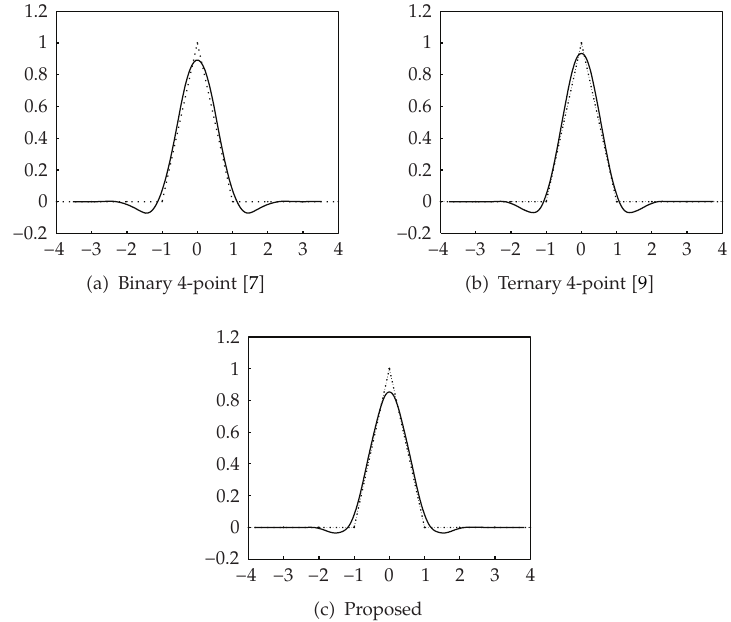
Figure 3: Support width of for binary, ternary, and proposed 4-point approximating schemes has been shown in (cid:2) a (cid:3) , (cid:2) b (cid:3) , and (cid:2) c (cid:3) , respectively. on the right will be at 7 (cid:2) 1 / 4 (cid:4) 1 / 4 2 (cid:4) · · · (cid:4) 1 / 4 k (cid:3) (cid:8) (cid:2) 7 / 4 (cid:3)(cid:2) (cid:27) (cid:27) ∞ ∞ 1 / 4 j (cid:3) (cid:4) (cid:2) 7 / 4 (cid:3)(cid:2) 1 / 4 j (cid:3) (cid:8) (cid:2) 15 / 4 (cid:3)(cid:2) 1 / (cid:2) 1 − 1 / 4 (cid:3)(cid:3) (cid:8) is (cid:2) 8 / 4 (cid:3)(cid:2) j (cid:8) 0 j (cid:8) 0